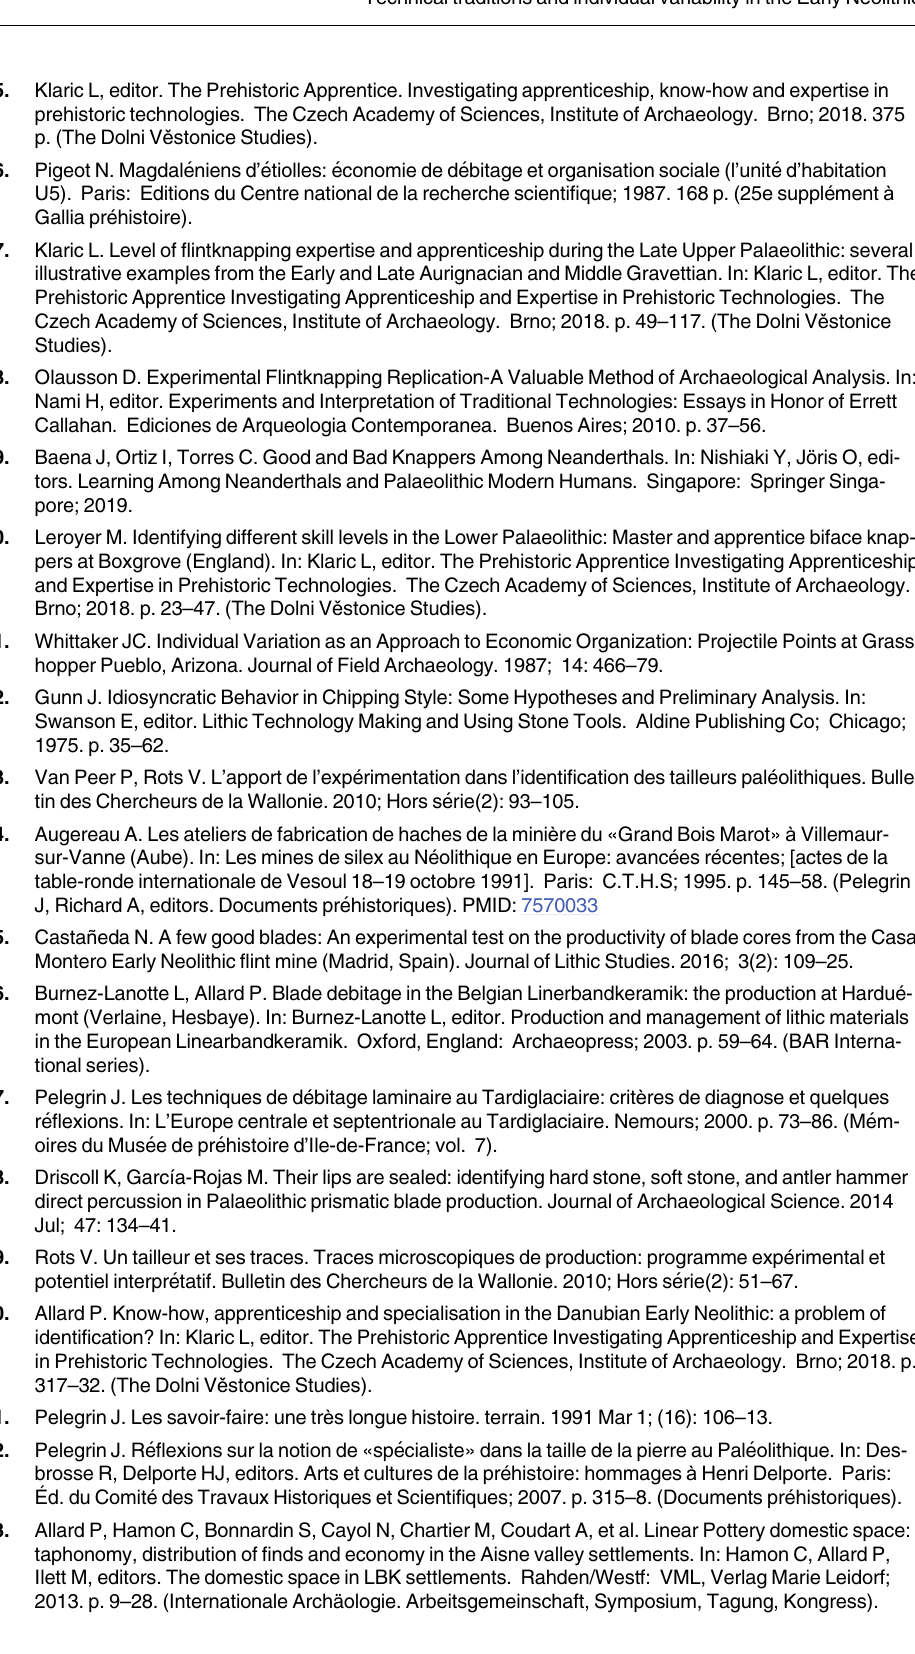
table-ronde internationale de Vesoul18–19 octobre 1991]. Paris: C.T.H.S; 1995. p. 145–58.(Pelegrin J, RichardA, editors. Documents pre´historiques). PMID: